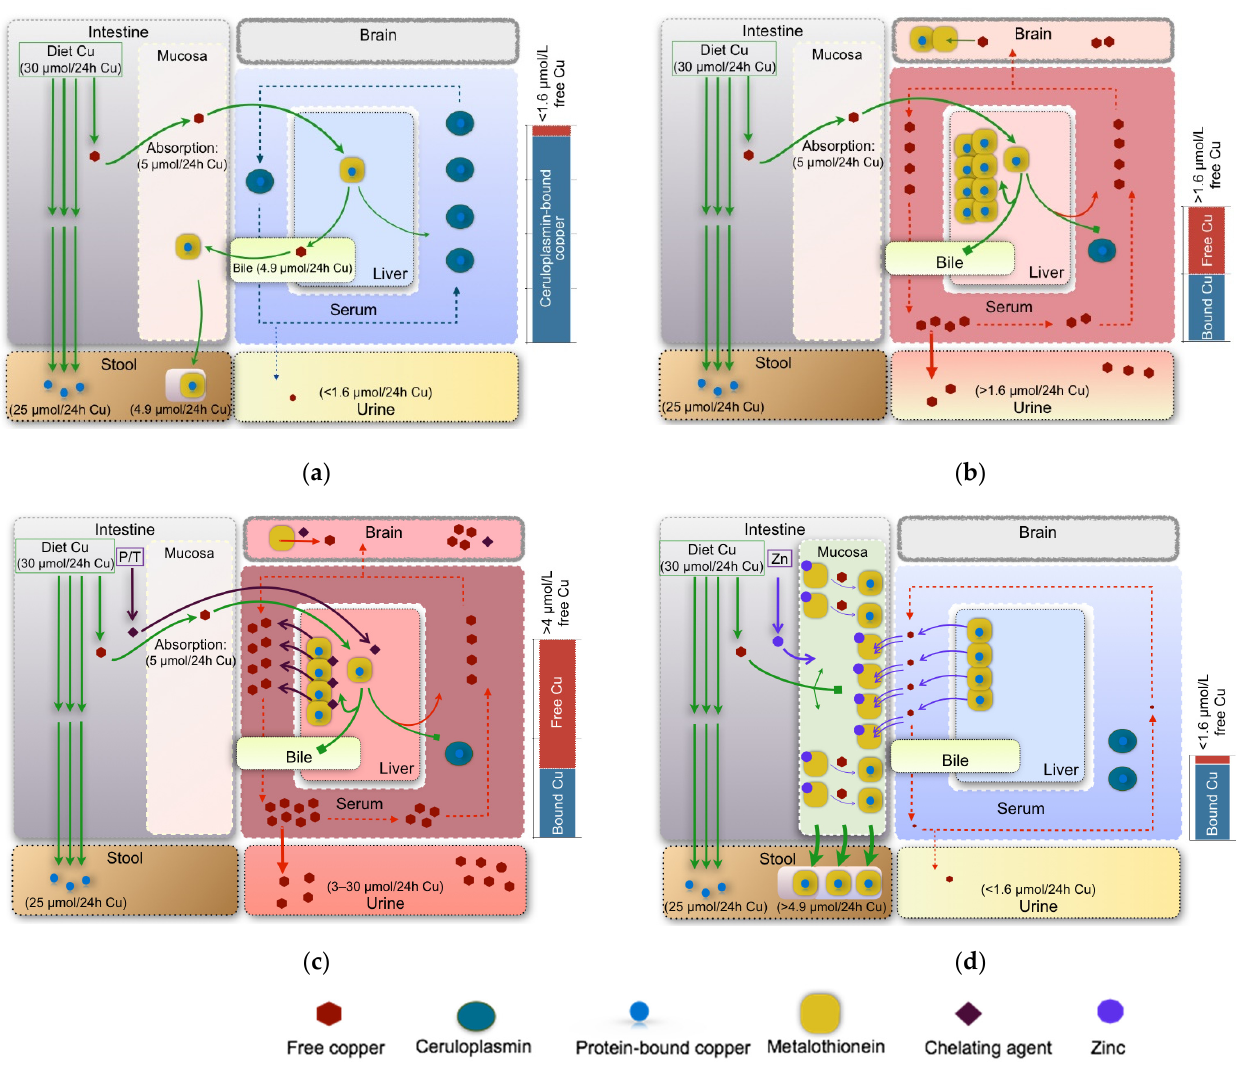
Figure 1. Schematic copper balance: Panel ( a ) reflects normal copper metabolism and a normal copper (Cu) balance in which the daily amount of copper ingested from the diet (equal to approximately 30 µmol or 2 mg per 24 h [24 h] [72,73]). Combined excretion of copper via feces and urine is about 25–30 µmol equal to 1.5–2 mg/24 h. Almost 85–95% of total serum copper is tightly bound to ceruloplasmin (shown with a sea green oval) [74], and the rest is in unbound or loosely bound (free) form (shown with a dark red hexagon). Panel ( b ) reflects impaired copper metabolism in Wilson’s disease (WD), in conditions in which the synthesis of holoceruloplasmin and the excretion of free copper with bile are diminished. Without treatment, the total excretion of copper via the urine and stools remains slightly lower than normal [37,61,75], thereby favoring copper toxicity. The serum free copper can be bound by metallothioneins (shown with yellow squares), deposited in organs